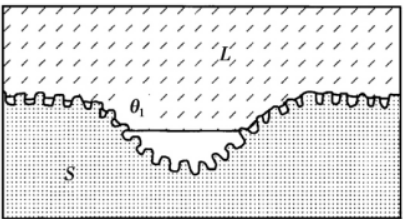
Figure 6. Herminghaus structure model (Reprinted with permission from Ref. [27]. 2000, Herminghaus, S.).